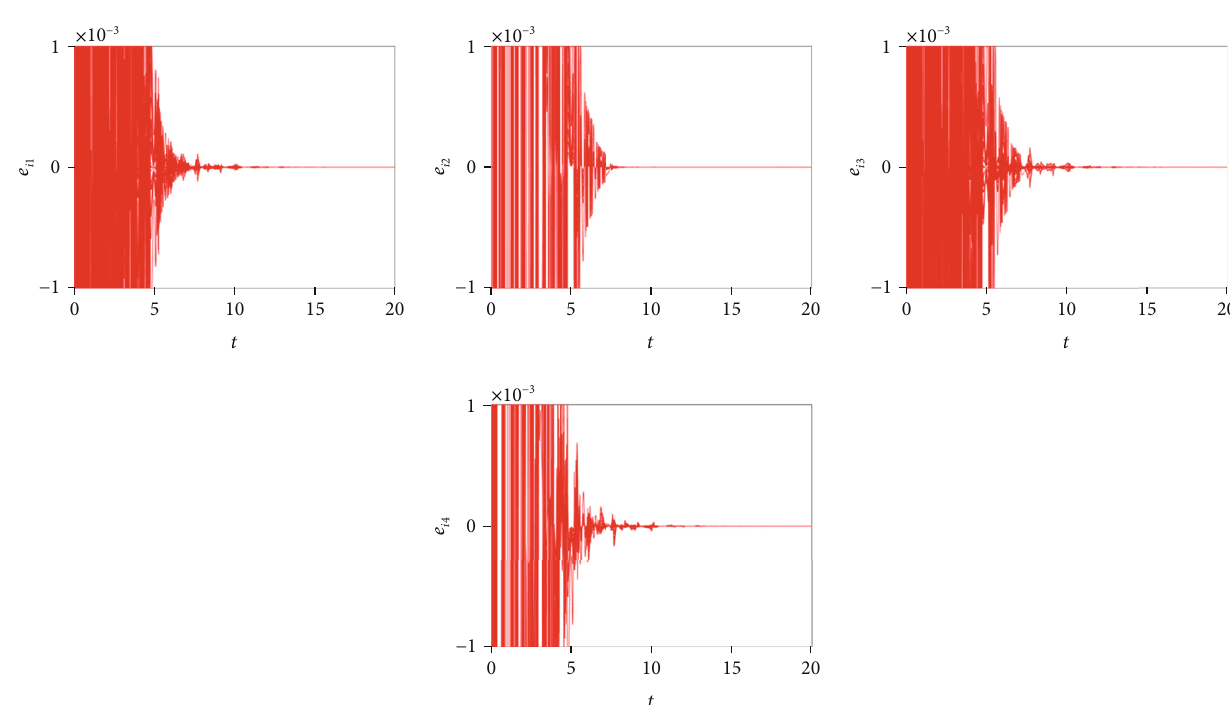
Figure 12: Synchronization errors e